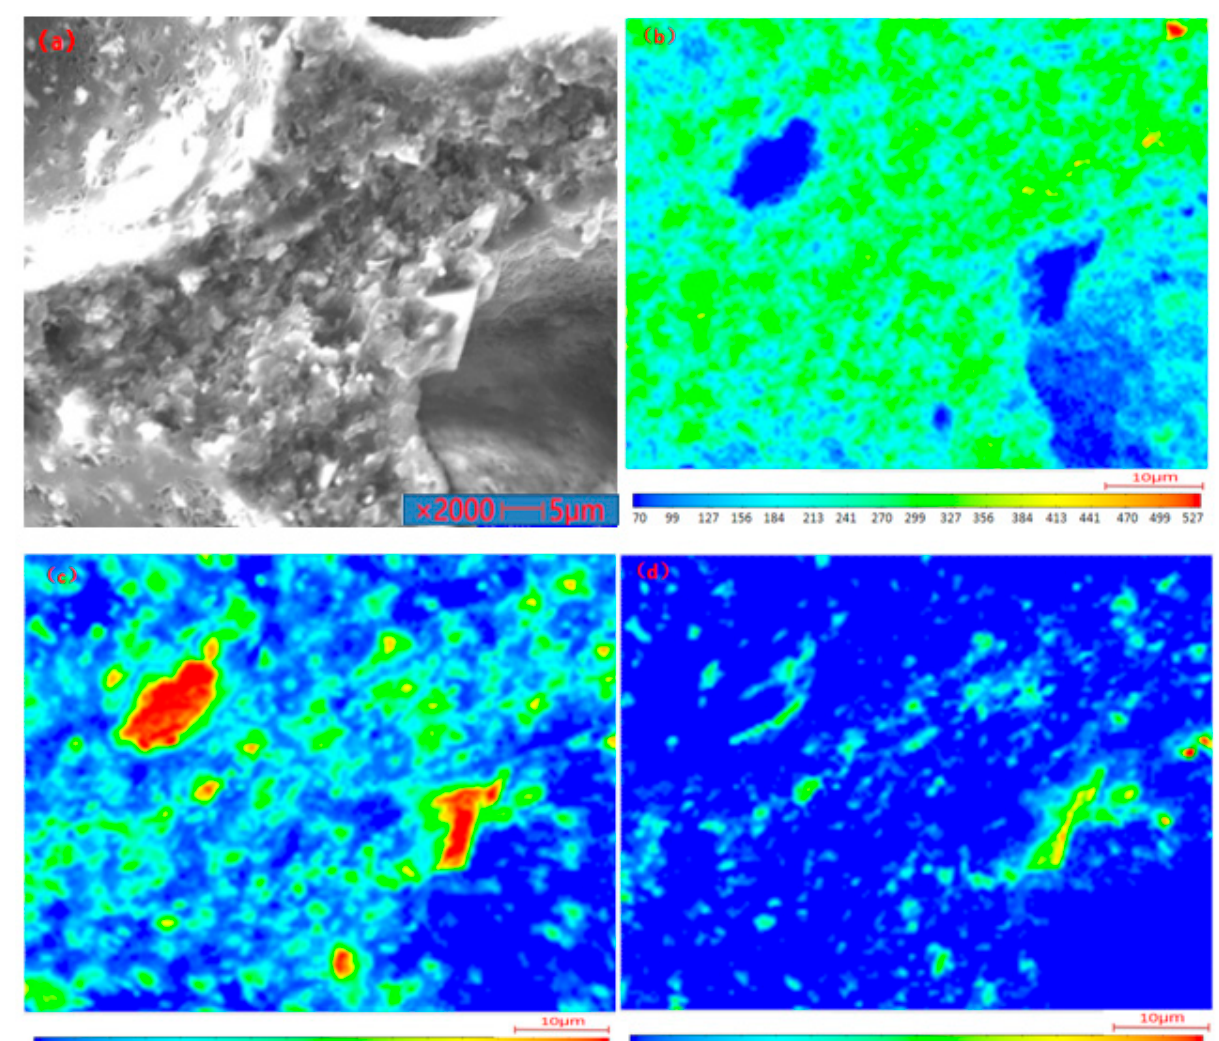
Figure 8. Mapping analysis of heated PVC film (370) by EPMA: ( a ) original image; ( b ) Cl element distribution; ( c ) Ca element distribution; ( d ) O element distribution.